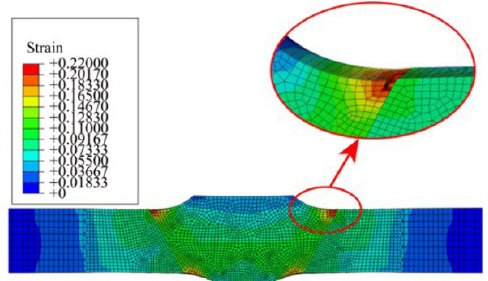
Figure 21. Simulation of tensile test load distribution on specimens with weld reinforcement [37]. Reprinted with permission from Ref. [37]. 2022, Elsevier.